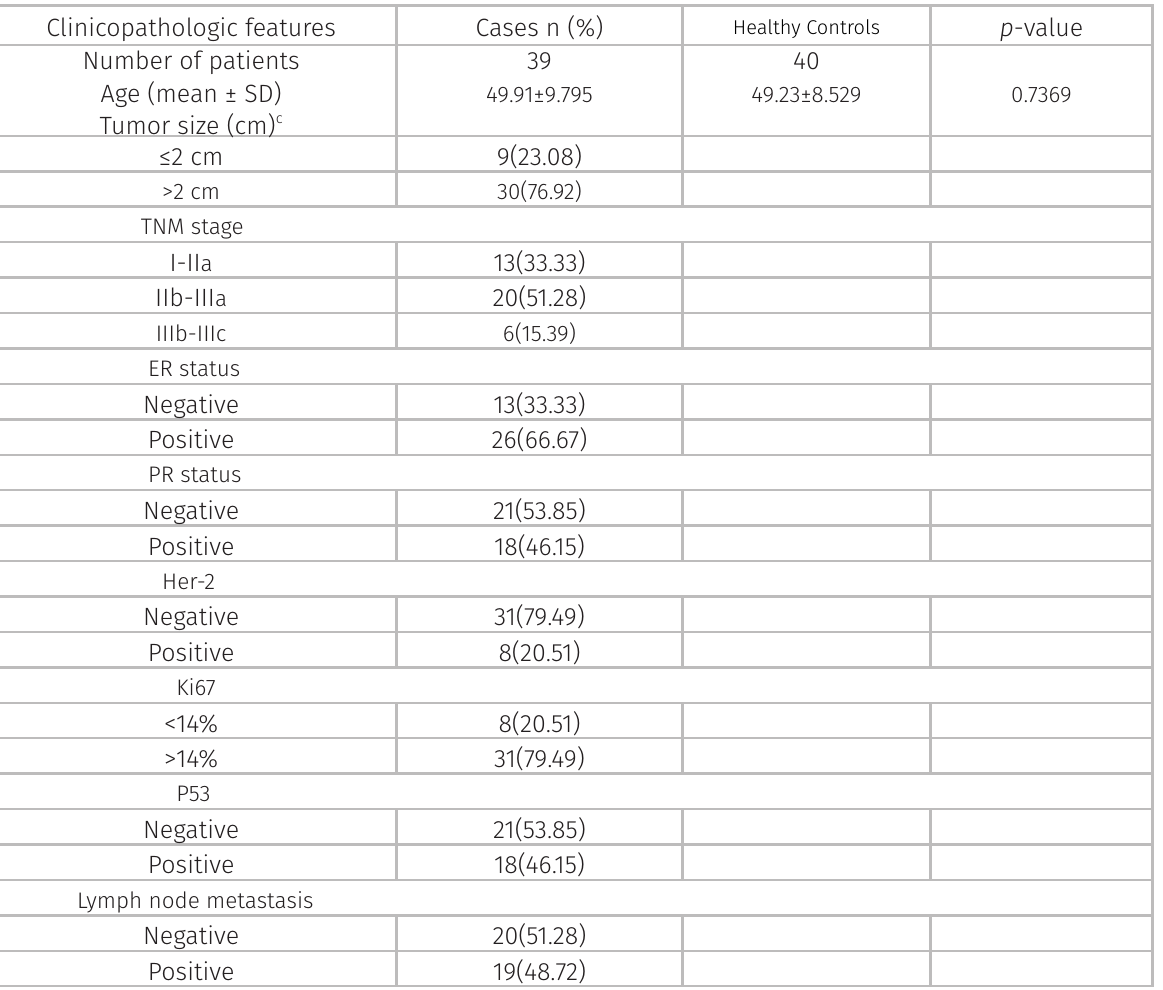
Table I. Clinical characteristics of the healthy volunteers, breast ductal cancer patients and pathological characteristics of breast ductal cancers in the discovery and validation